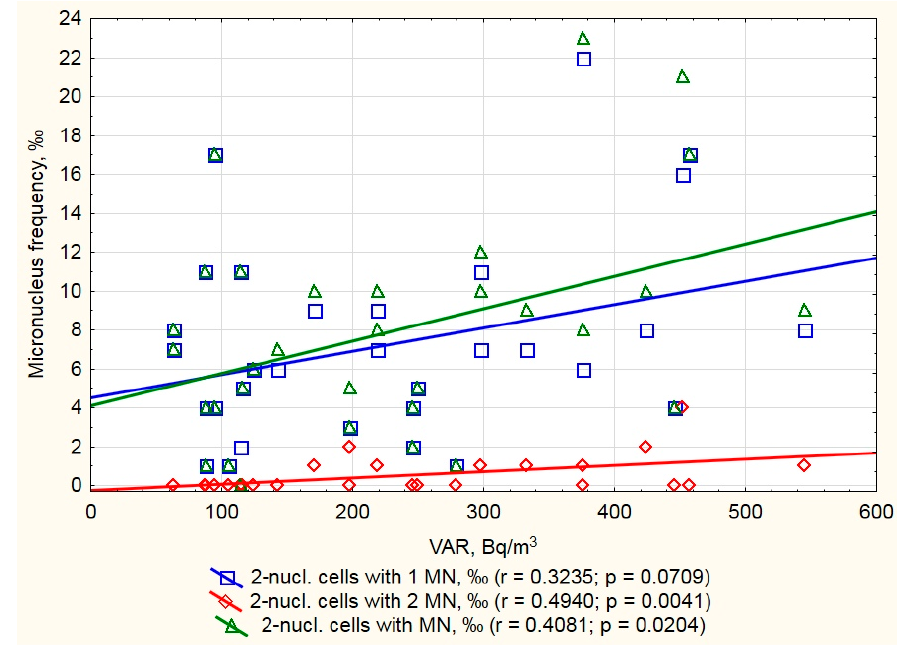
Figure 3. Frequency of peripheral lymphocytes with micronuclei (MN) and residential VAR in studied inhabitants.